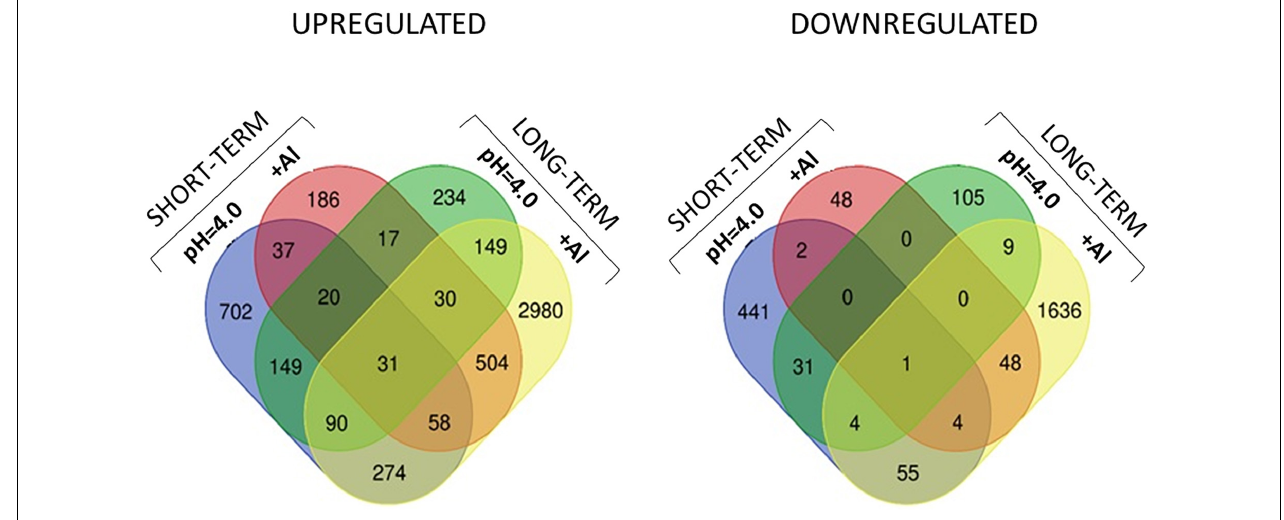
FIGURE 11 | Venn diagrams showing common and specific DEGs upregulated and downregulated between all experimental